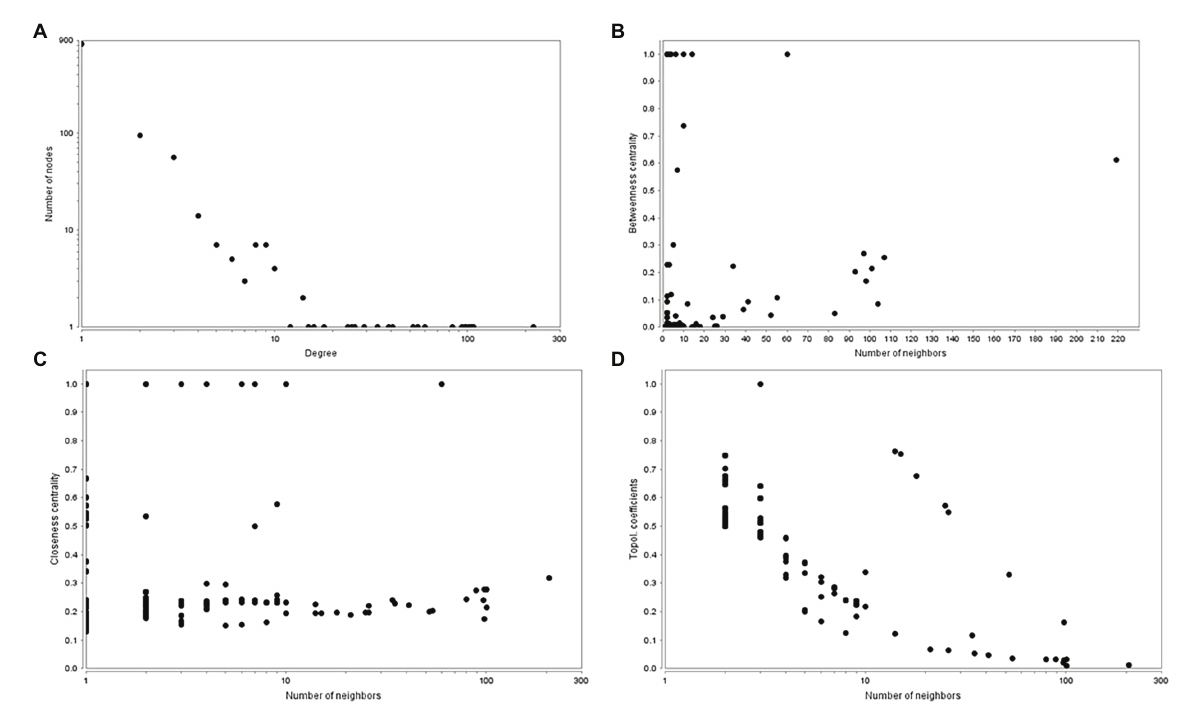
FIGURE 6 Topological properties of the PPINs. (A) . Degree of distribution. (B) . Betweenness centrality. (C) . Closeness centrality. (D) . Topological